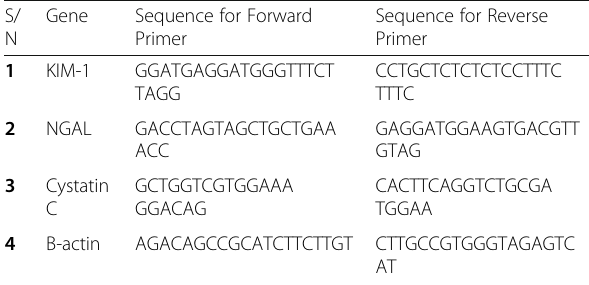
Table 1 Gene Expression Analysis by RT-PCR